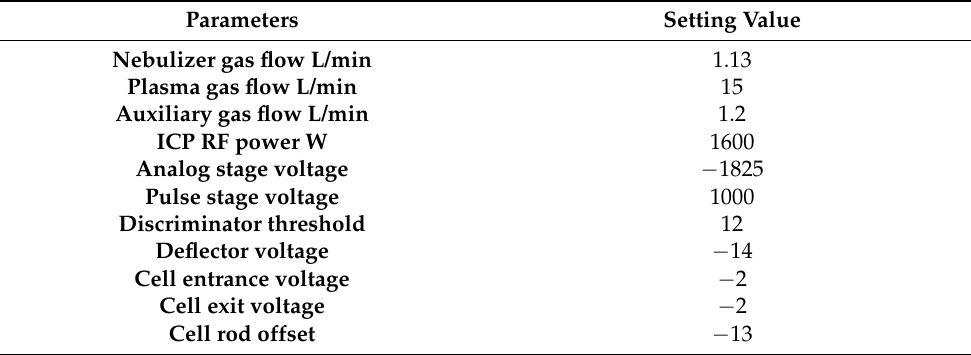
Table 1. ICP MS instrument